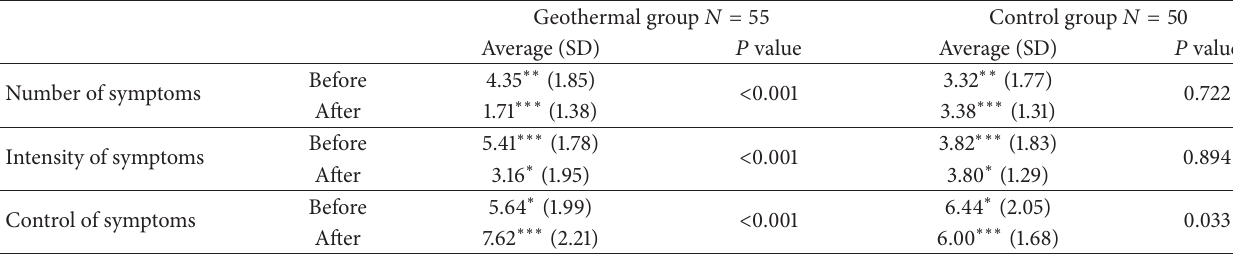
Table 3: Comparison of the effect on distress in the study’s groups.